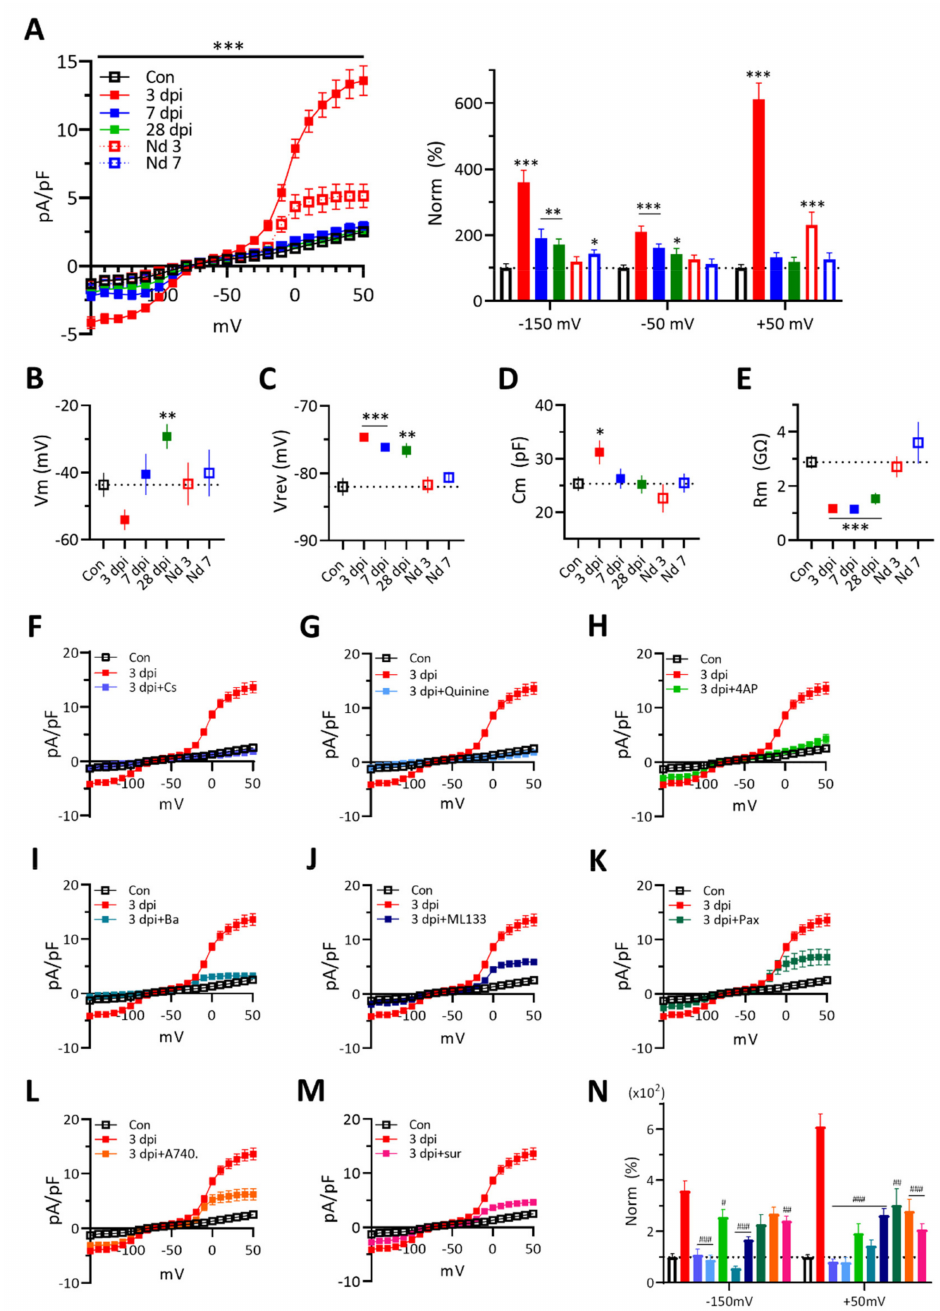
Figure 4. Changes of membrane current density of GFP (+) microglia in response to a voltage-ramp after ATP injection. Two-way ANOVA with Tukey’s test or two-tailed t -test for comparing the experimental group to the control group (*) or to the 3 dpi group (#) (*, # for p < 0.05; **, ## for p < 0.01; ***, ### for p < 0.001). ( A ). Left : Voltage-activated current density of microglial cells at different conditions. The current density was averaged by 10 mV increment. Two-way ANOVA with Tukey’s test. Right : Normalized current densities at − 150, − 50 and +50 mV. Two-tailed t -test. ( B ). Resting membrane potential of microglia. Two-tailed t -test. ( C ). Reversal potential of microglia. Two-tailed t -test. ( D ). Membrane capacitance of microglia. Two-tailed t -test. ( E ). Membrane resistance of microglia. Two-tailed t -test. ( F – M ). Membrane current density changes of 3 dpi microglia to internal cesium (Cs 2+ ) solution (F) or in bath containing quinine (1 mM) ( G ), 4-AP (1 mM) ( H ), BaCl 2 (200 µ M) ( I ), ML133 (20 µ M) ( J ), paxilline (50 µ M) ( K ), A740003 (100 µ M) ( L ), suramin (500 µ M) ( M , N ). Normalized current densities of microglia from ( F – M ) at − 150, − 50 and +50 mV. The bar color indicates the same color of each molecule tested in ( F – M ). Two-tailed t